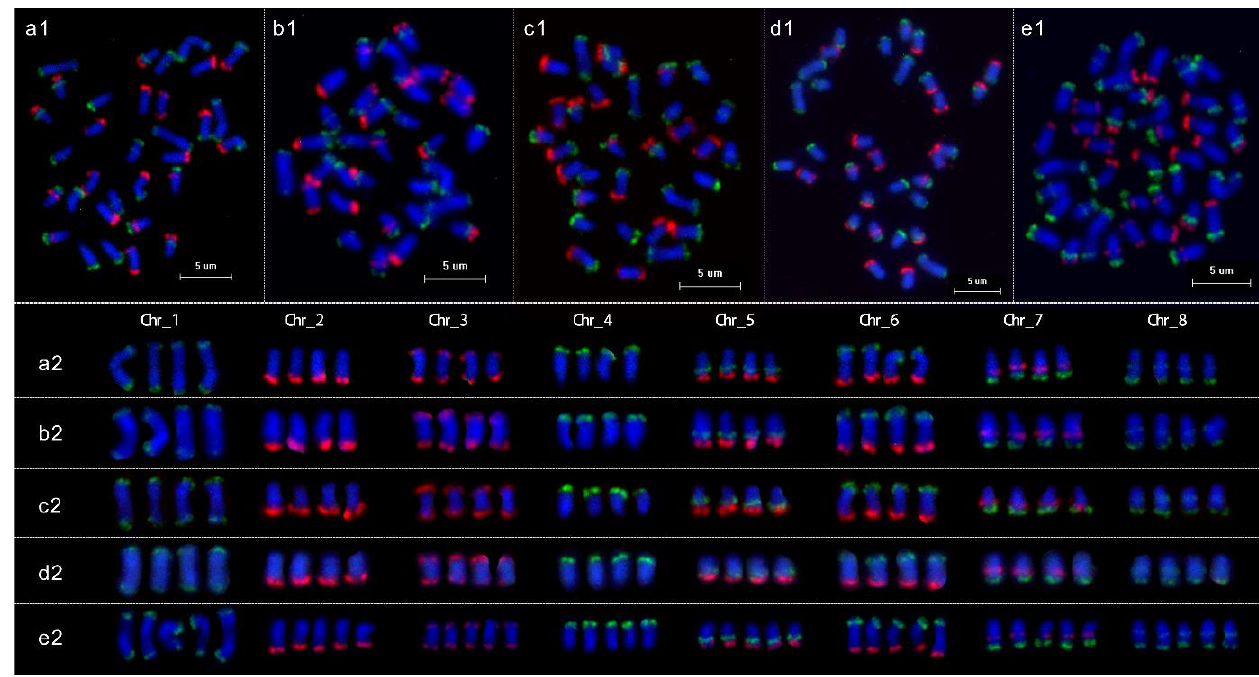
Figure 4. Accurate chromosome identification in metaphase spreads from Chinese cherry. ( a1 ‒ e1 ) FISH mapping of the two single copy oligonucleotide probe sublibraries on chromosomes. P. pseudocerasus _HC ( a1 ), P. pseudocerasus _BZ ( b1 ), P. pseudocerasus _HF ( c1 ), P. pseudocerasus _PJHH ( d1 ), and P. pseudocerasus _FM2 ( e1 ), respectively. ( a2 ‒ e2 ) Homologous chromosomes were digitally excised from ( a1 ‒ e1 ) and paired.